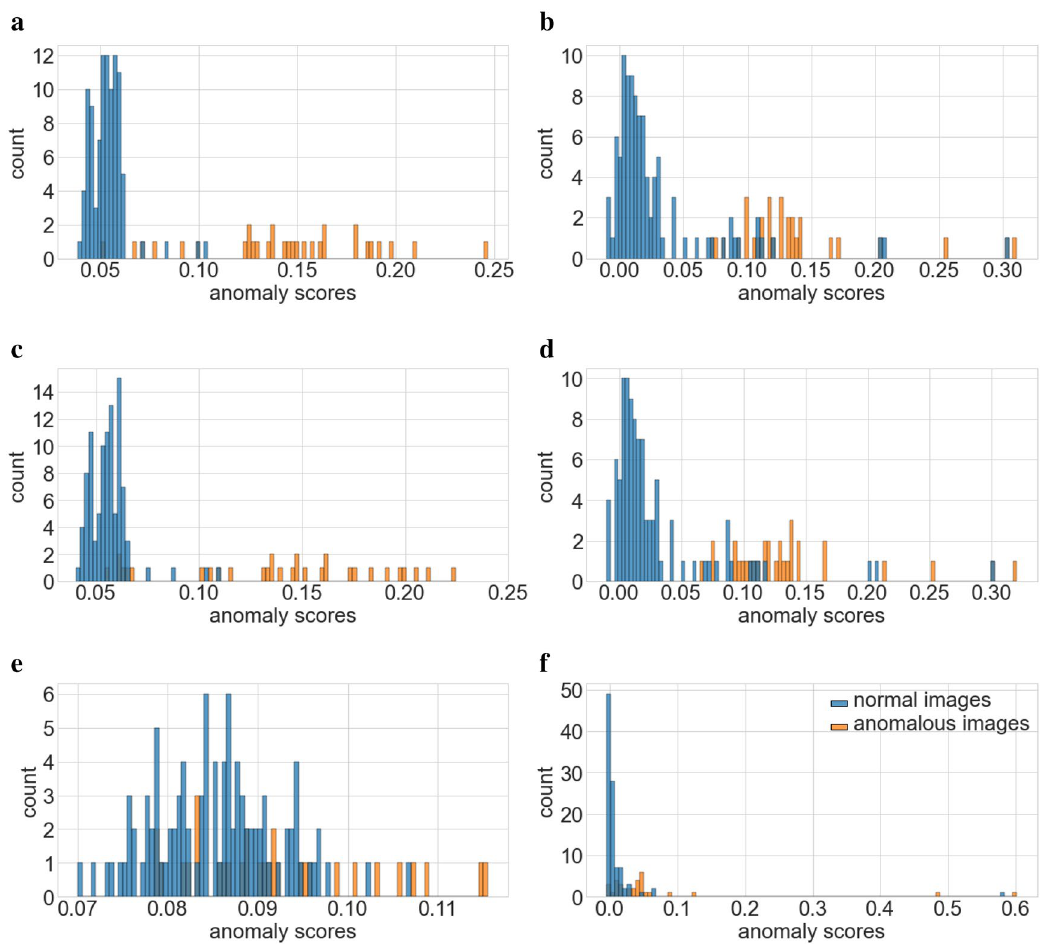
images, d for the bottleneck-values approach applied on the modi- fied images, e for the reconstruction error approach applied on the greyscaled images, f for the bottleneck-values approach applied on the greyscaled images